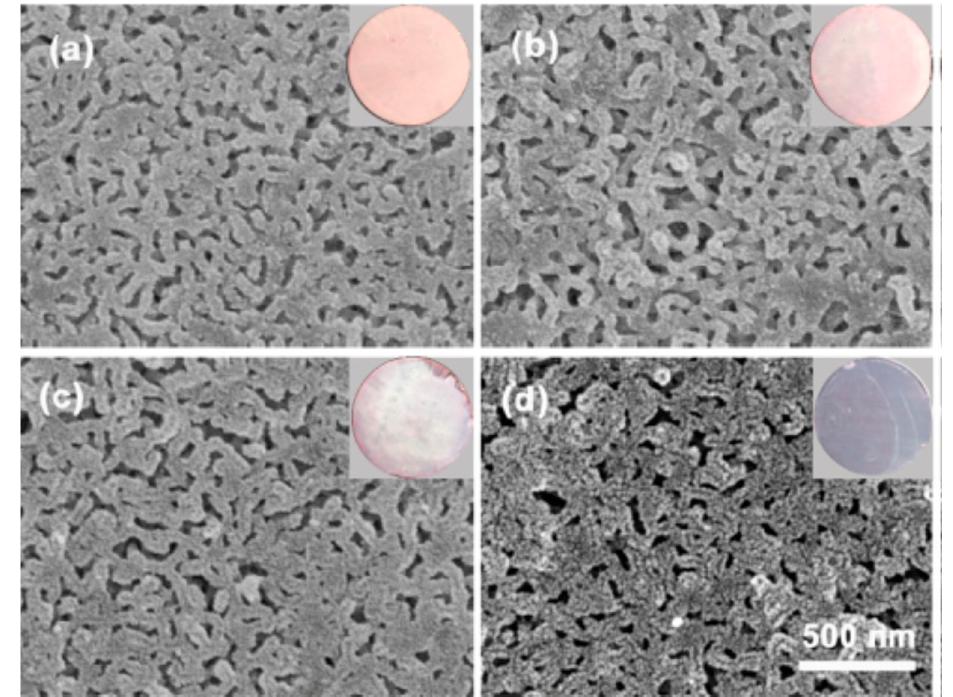
Figure 9. SEM and digital images of PDMAEM- b -PS/AuNPs membranes prepared with concentrations of HAuCl 4 ( a ) 0.5 mg ⋅ mL − 1 ; ( b ) 1.25 mg ⋅ mL − 1 ; ( c ) 2.5 mg ⋅ mL − 1 ; ( d ) 5.0 mg ⋅ mL − 1 . ((Reproduced by permission of the Royal Society of Chemistry from Ref. [50]–Reproduced by permission of The Royal Society of Chemistry).